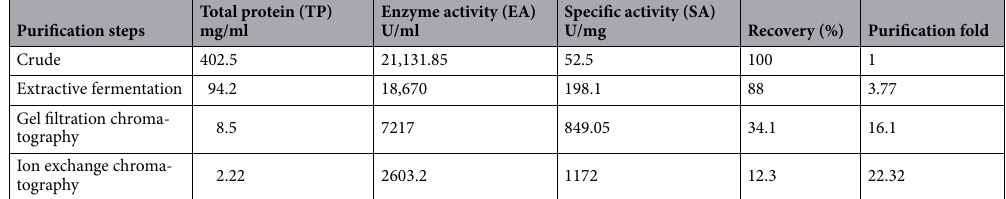
Table 5. Increase of purity fold corresponding to various affinity separation operations carried out and their effect on the yield and specific enzyme activity of fibrinolytic protease. Relative uncertainty for the total protein, enzyme activity and specific activity are u r (TP) = 0.2 mg/ml, u r (EA) = 0.02 U/ml, u r (SA) = 0.02